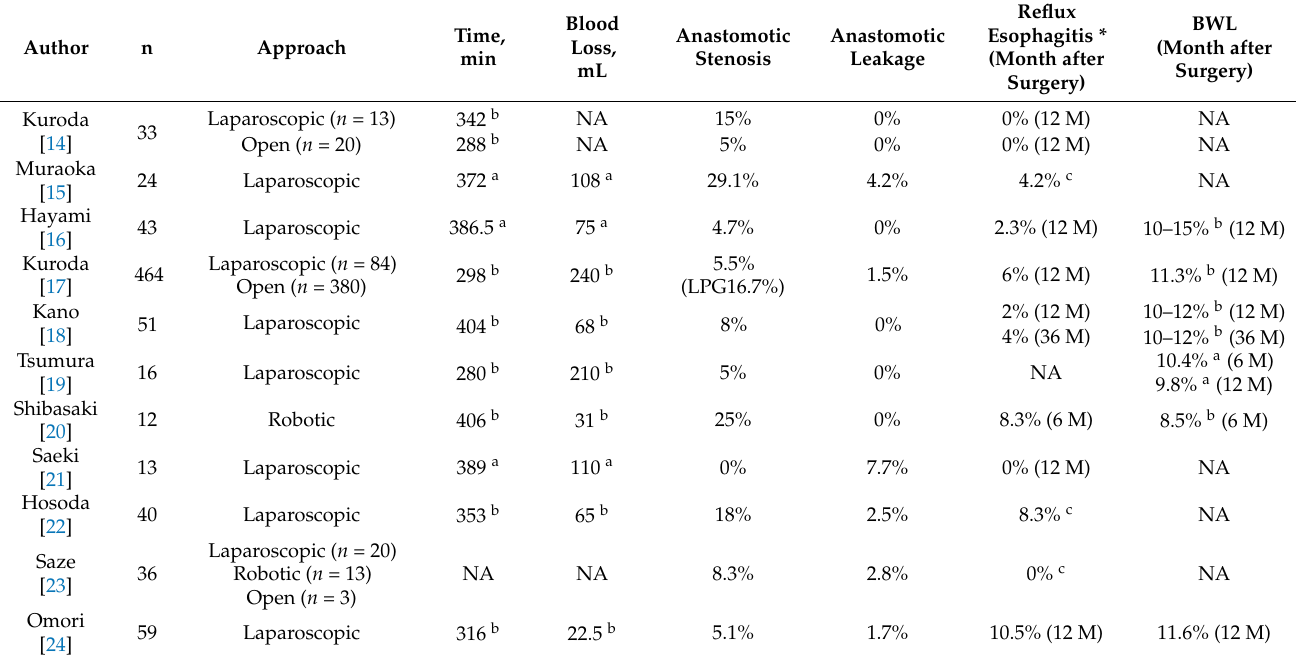
Table 1. Summary of LPG-DFT